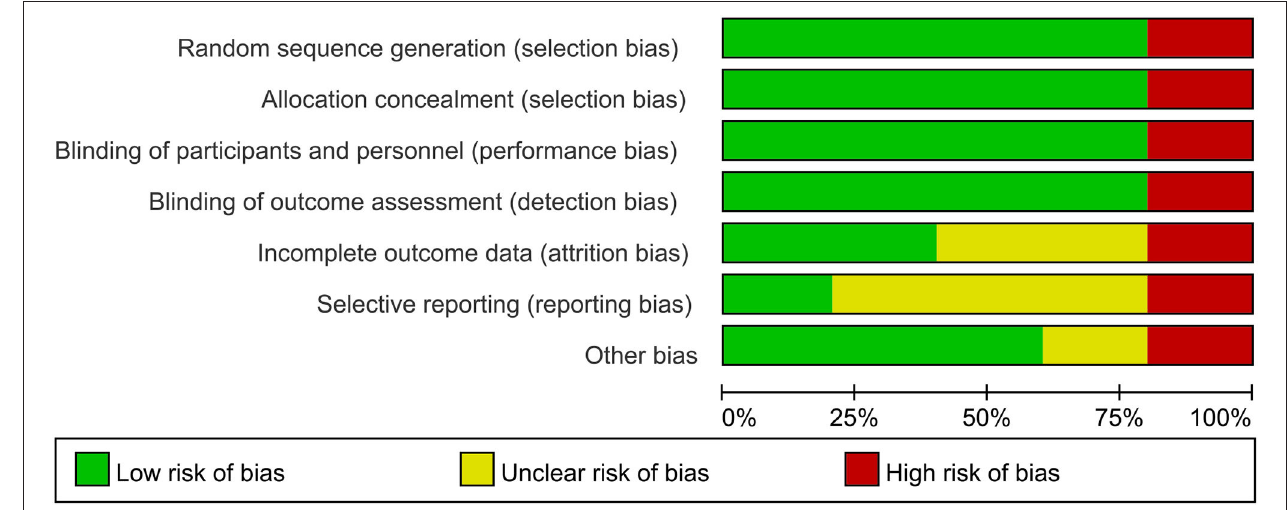
FIGURE 3 | The risk of bias graph.